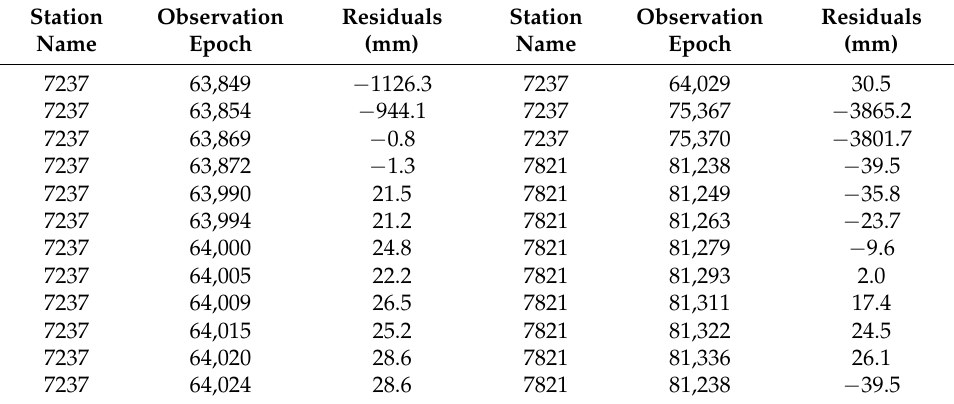
Table 2. An example of SLR residuals corresponding to the reduced-dynamic orbit on 6 December